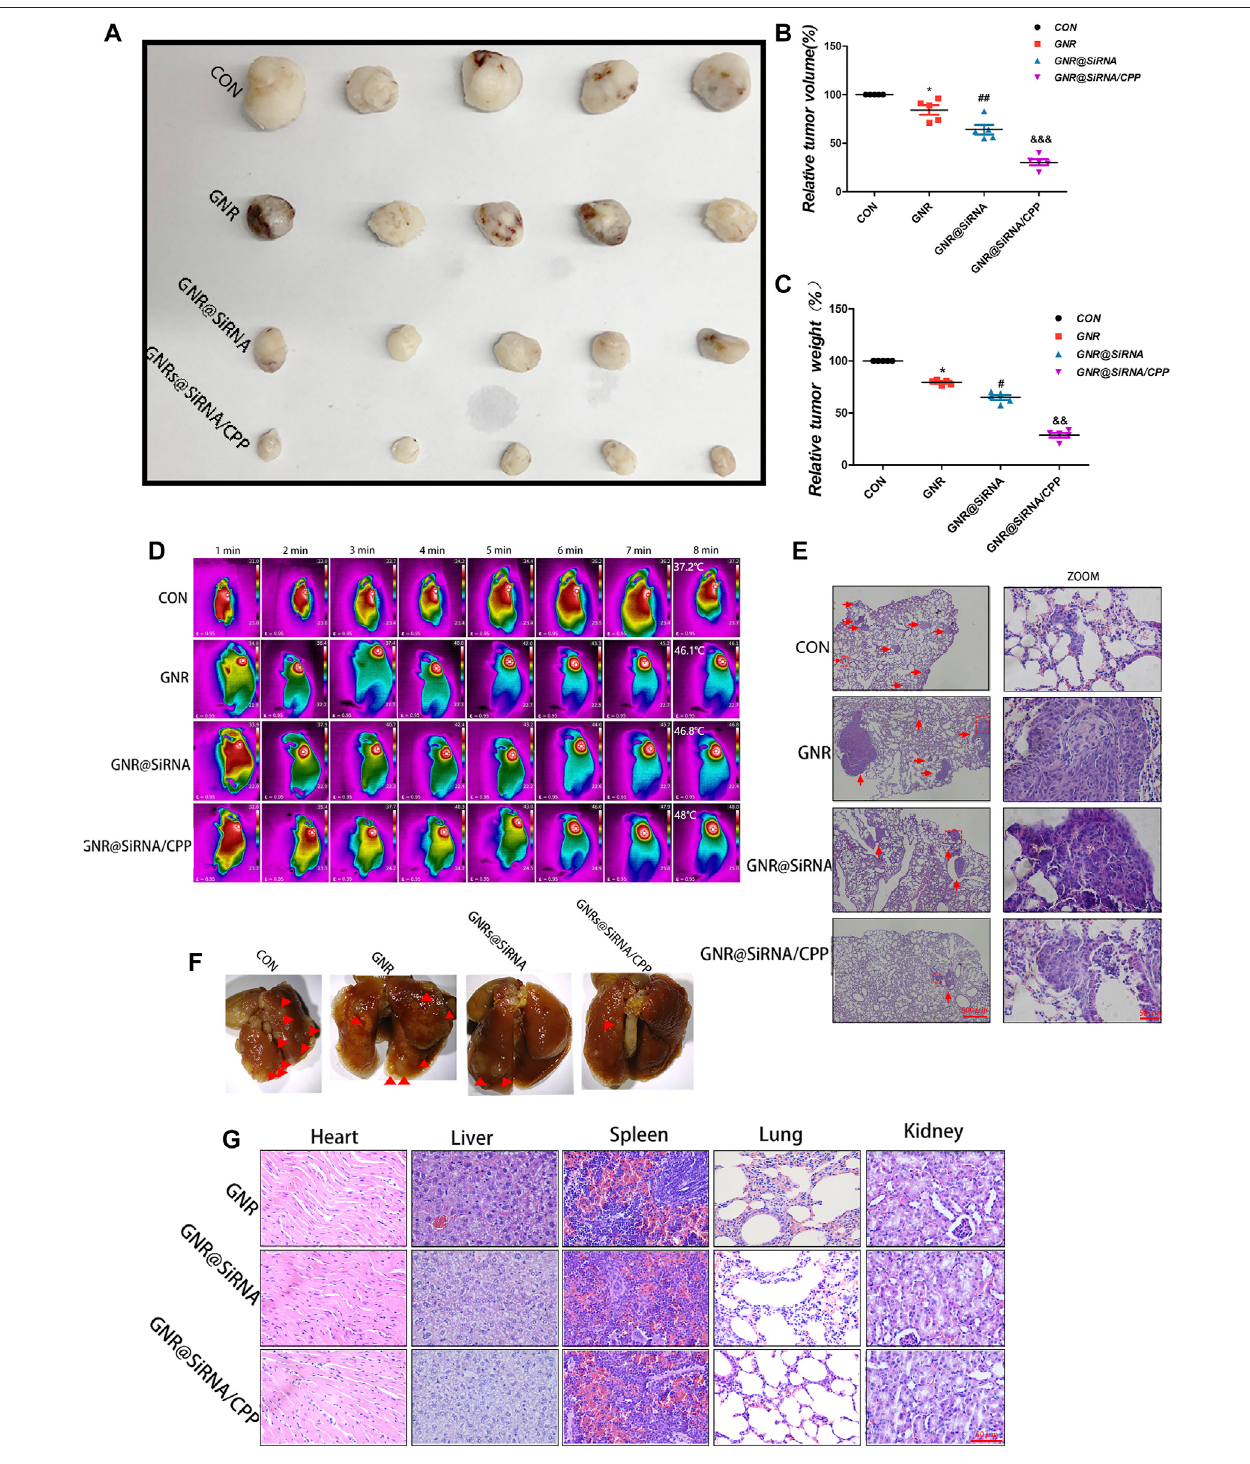
FIGURE 6 | Nanoplatforms inhibit the growth of OS subcutaneously and pulmonary metastasis in vivo . (A – C) Tumor formation in different groups. (D) Thermographs of mice recorded in different groups by NIR irradiation for various times. (E, F) Photographs and H&E staining of lung tissues in different groups. (G) H&E staining of organ tissues of mice in different groups. ( n (cid:2) 5 per group; * p < 0.05 vs. CON group; # p < 0.05 or ## p < 0.01 vs. GNR group; && p < 0.01 or &&& p < 0.001 vs. GNR@siRNA group).